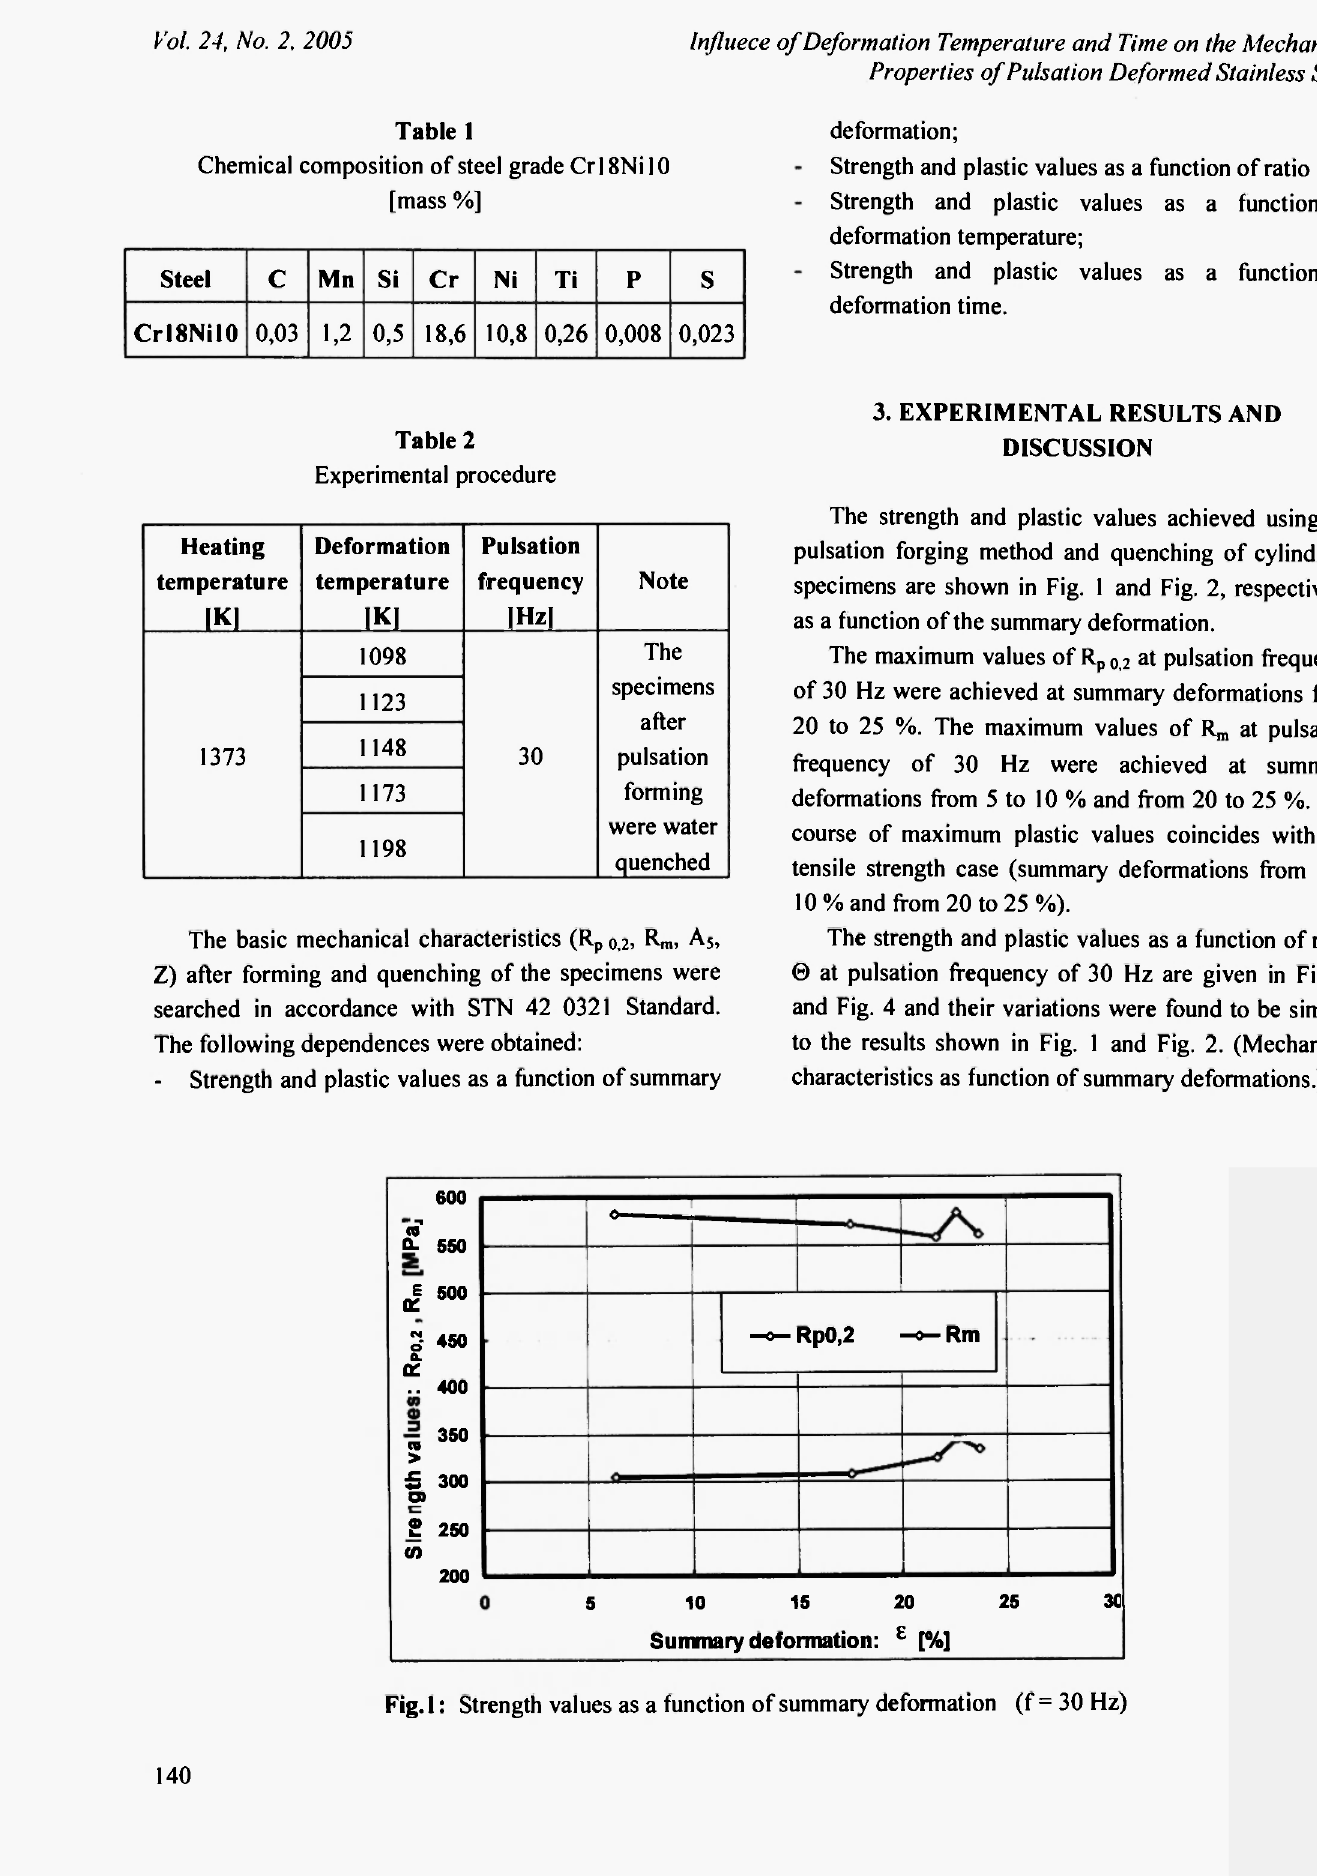
Fig.l : Strength values as a function of summary deformation (f = 30